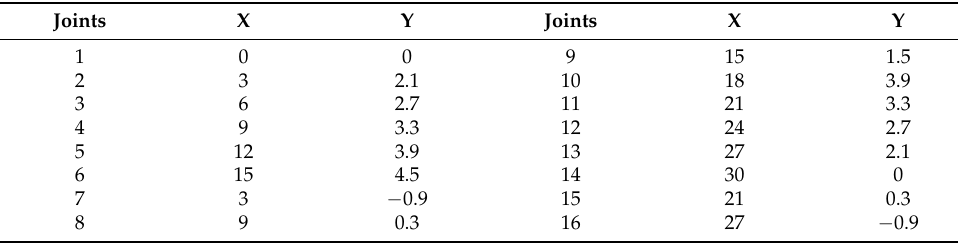
Table 3. Number and position of nodes.